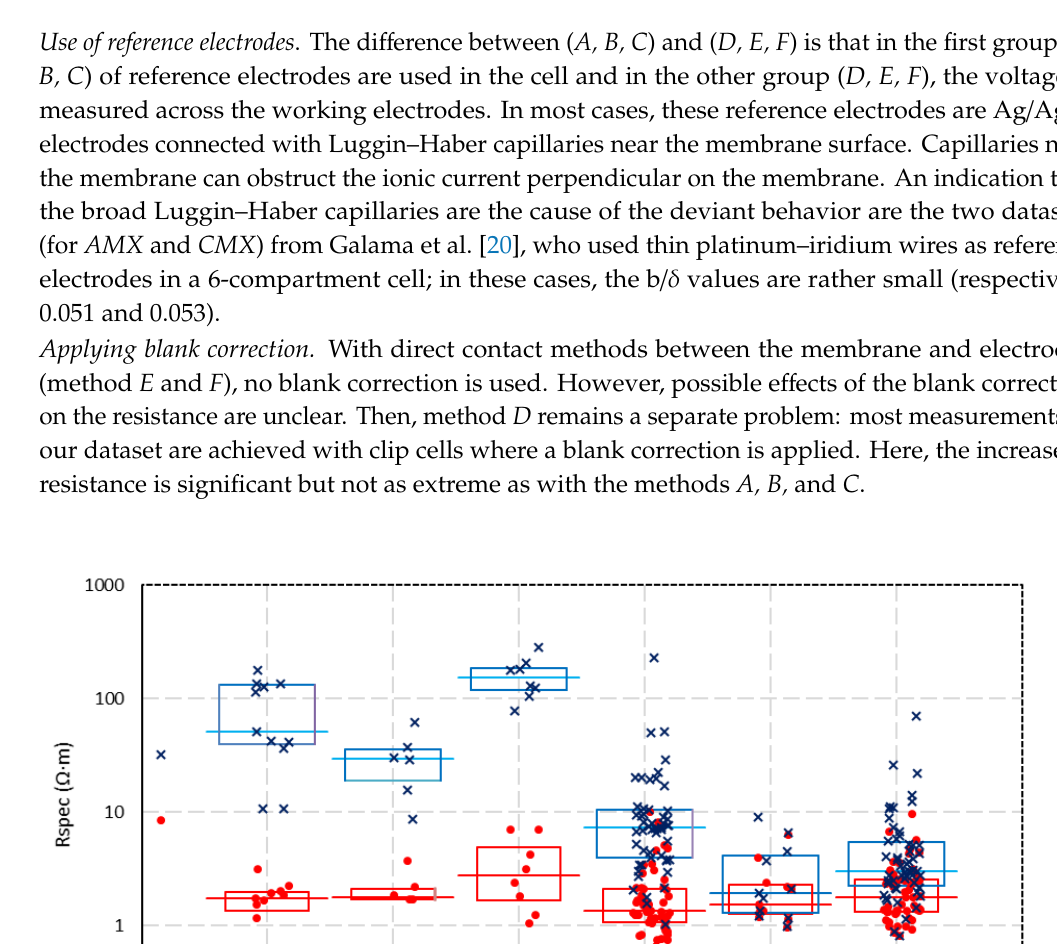
Figure 7. Specific resistance at 0.5 mol/L (red dots) and 0.005 mol/L (blue crosses) as calculated with the 1-thread model, specified for the different measuring methods (A, B...F). To prevent overlap of the data points, X-values are slightly offset on the X-axis. The horizontal lines indicate the median value for each data cluster, while the boxes indicate the lower and upper quartiles.